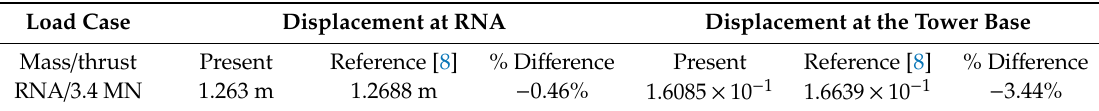
Table 7. Static deformation of the baseline 10 MW on jacket.